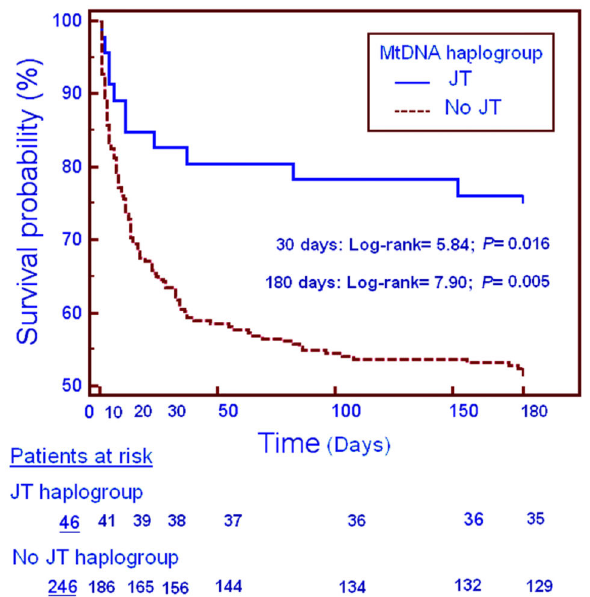
Figure 2. Cumulative proportion of patients' survival at 30 days and 6 months according to mtDNA haplogroup JT versus no